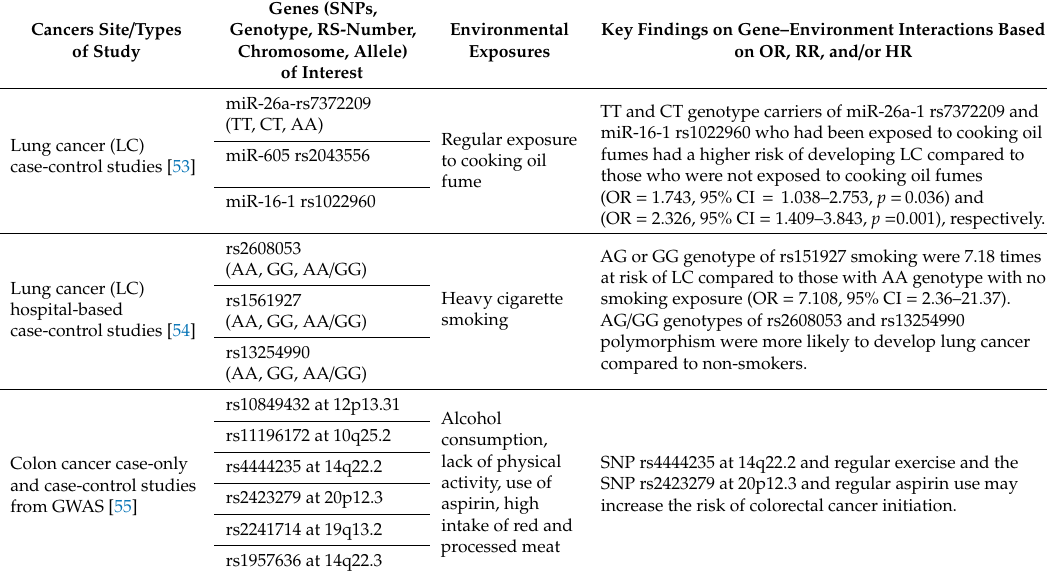
Table 1. Major findings on gene–environment interactions associated with human cancers. Genes (SNPs, Cancers Site / Types Genotype, RS-Number, Environmental Key Findings on Gene–Environment Interactions Based of Study Chromosome, Allele) Exposures on OR, RR, and / or of Interest